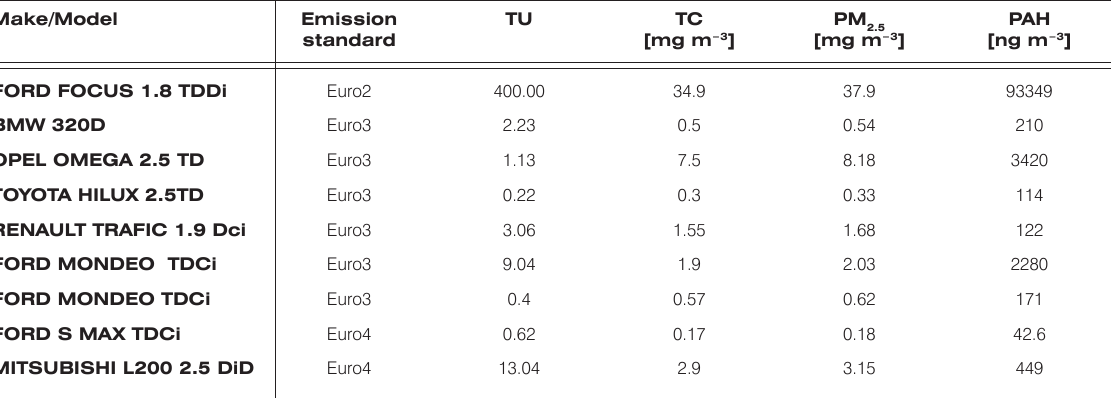
Table 2. Total carbon (TC), PM and PAH content and ecotoxicity of particulates collected near the tailpipes of tested vehicles. Toxicity is 2.5 expressed as the dimensionless Toxic Unit